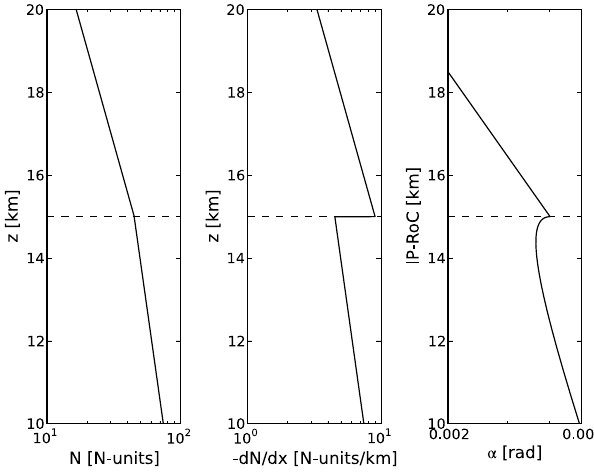
Figure B1. Example profiles of (from left to right) N , − d N/ d x and α when there is a discontinuity in d N/ d x at x 0 = 15km. (For this plot, N = 10 6 (n − 1 ) as